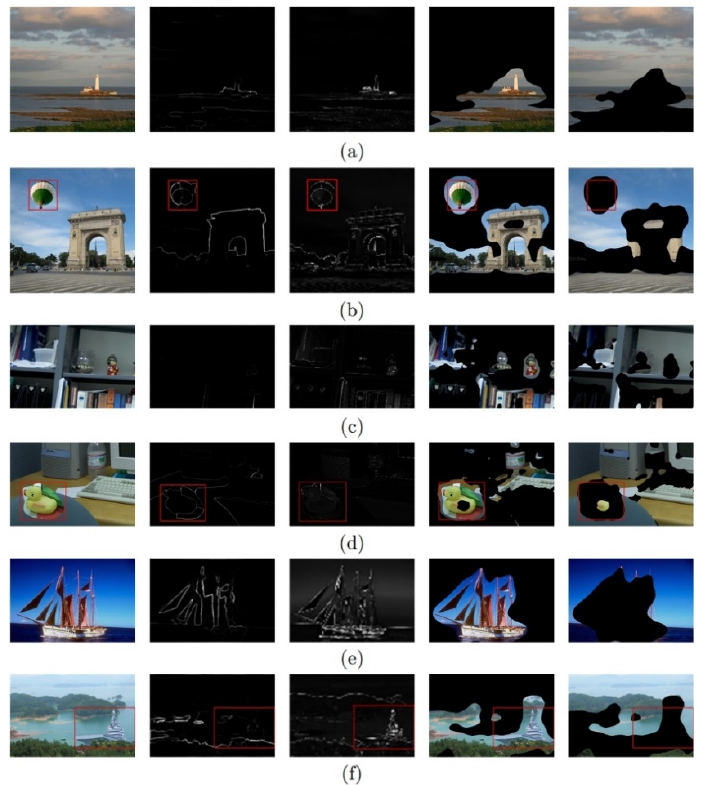
Figure 12. Images detected successfully by the proposed algorithm but failed to be detected by the comparison algorithm in the dataset. From left to right are the color images, the chroma detection results of CCW, the results of the sharpness detection operator, and the ROI and RONI given by the CCW salient map. ( a , c , e ) Untampered images in Tampering ImageNet, Columbia, and CASIA ITDE V2.0, respectively; ( b , d , f ) tampered images in Tampering ImageNet, Columbia, and CASIA ITDE V2.0, respectively. Table 4. Quantitative results of the proposed method in terms of three evaluation metrics, with a comparison to existing related